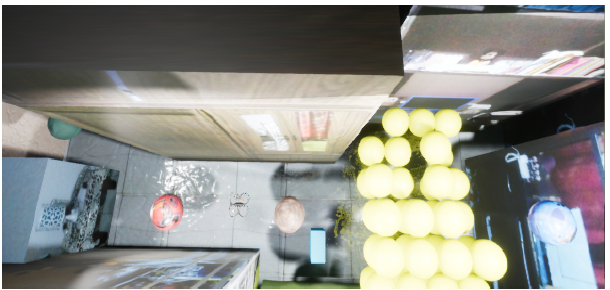
Figure 21. Representation of centroid created by 3D mesh navigations.